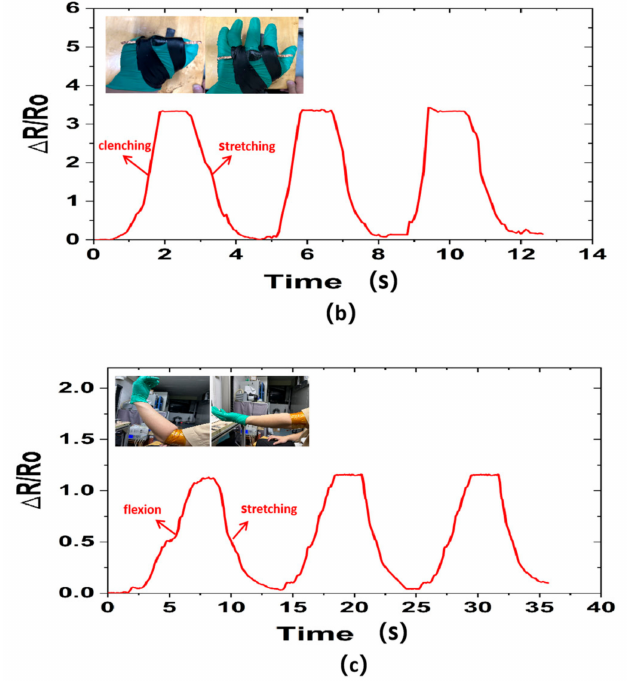
Figure 6. ( a ) flexion and extension of fingers; ( b ) fist clenching and stretching; ( c ) flexion and stretching of the